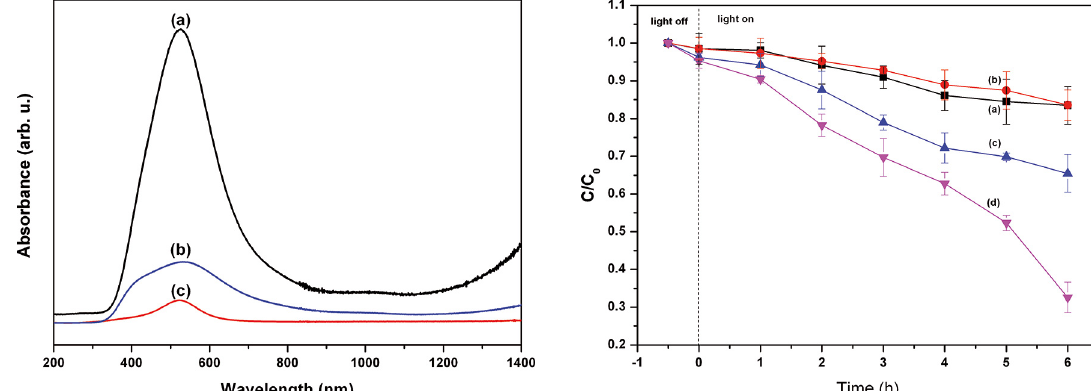
(OH)PO prepared 2 4 COO) •H O 3 2 2